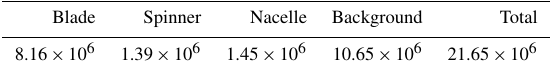
Table 1. Grid cells in the 120 ◦